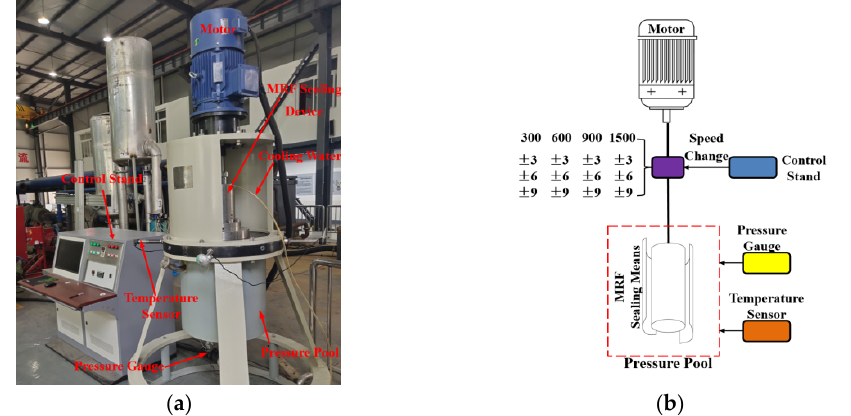
Figure 3. Experimental bench of MR fluid sealing device for main shaft of hydraulic turbine: ( a ) photograph; ( b ) diagram.